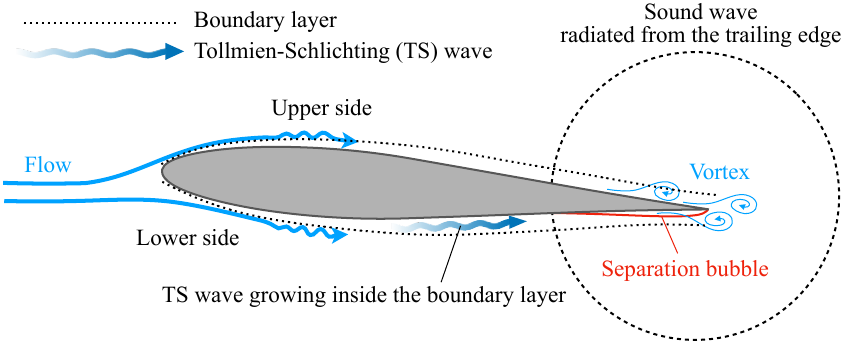
Figure 1. Schematic diagram of the generation of trailing-edge